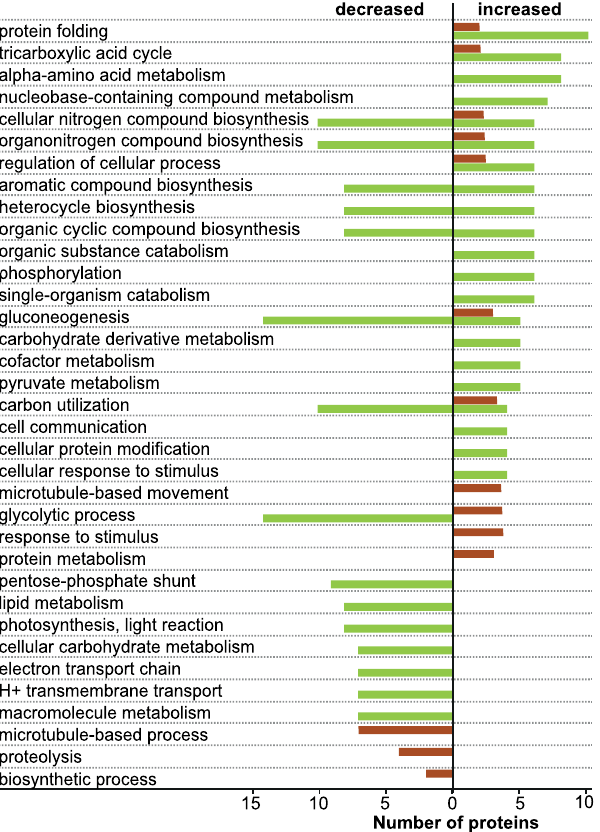
Figure 3. Counts of differently abundant proteins in Amphistegina gibbosa in response to chronic thermal stress in the host (brown) and the symbiont (green) compartment grouped by biological process gene ontology terms. Position of bar indicates if proteins were more (right side) or less (left side) abundant than in the